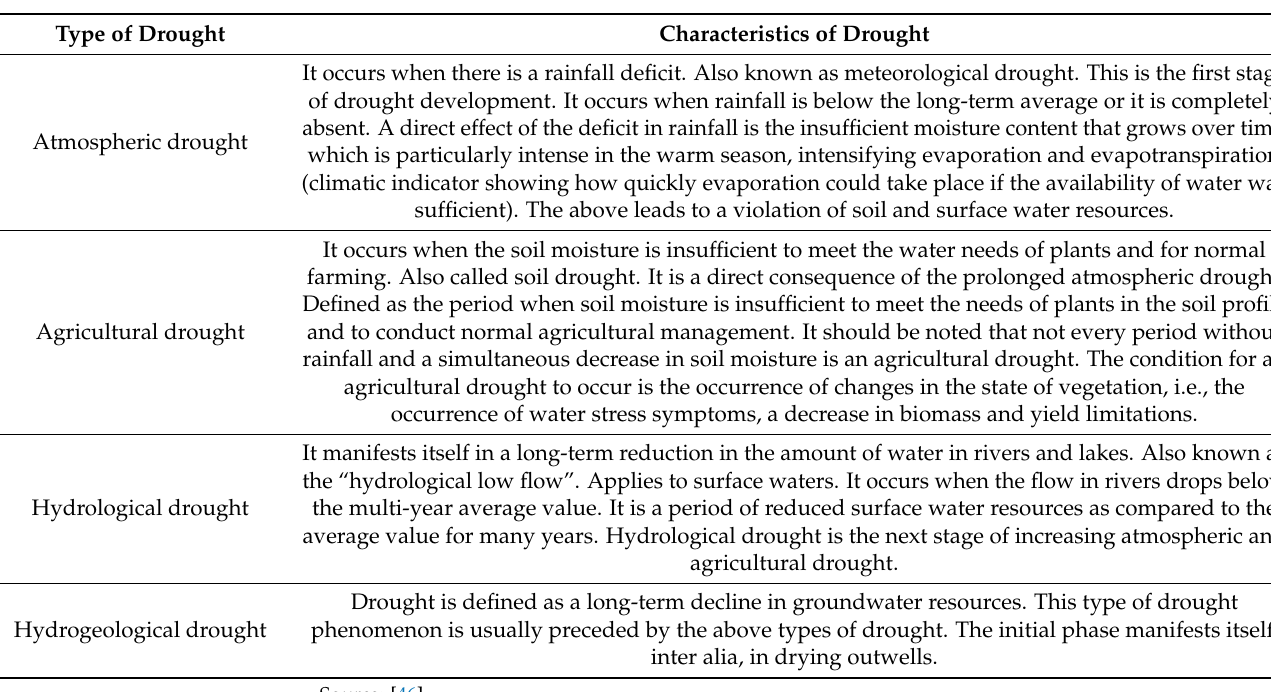
Table 8. Types of drought and their